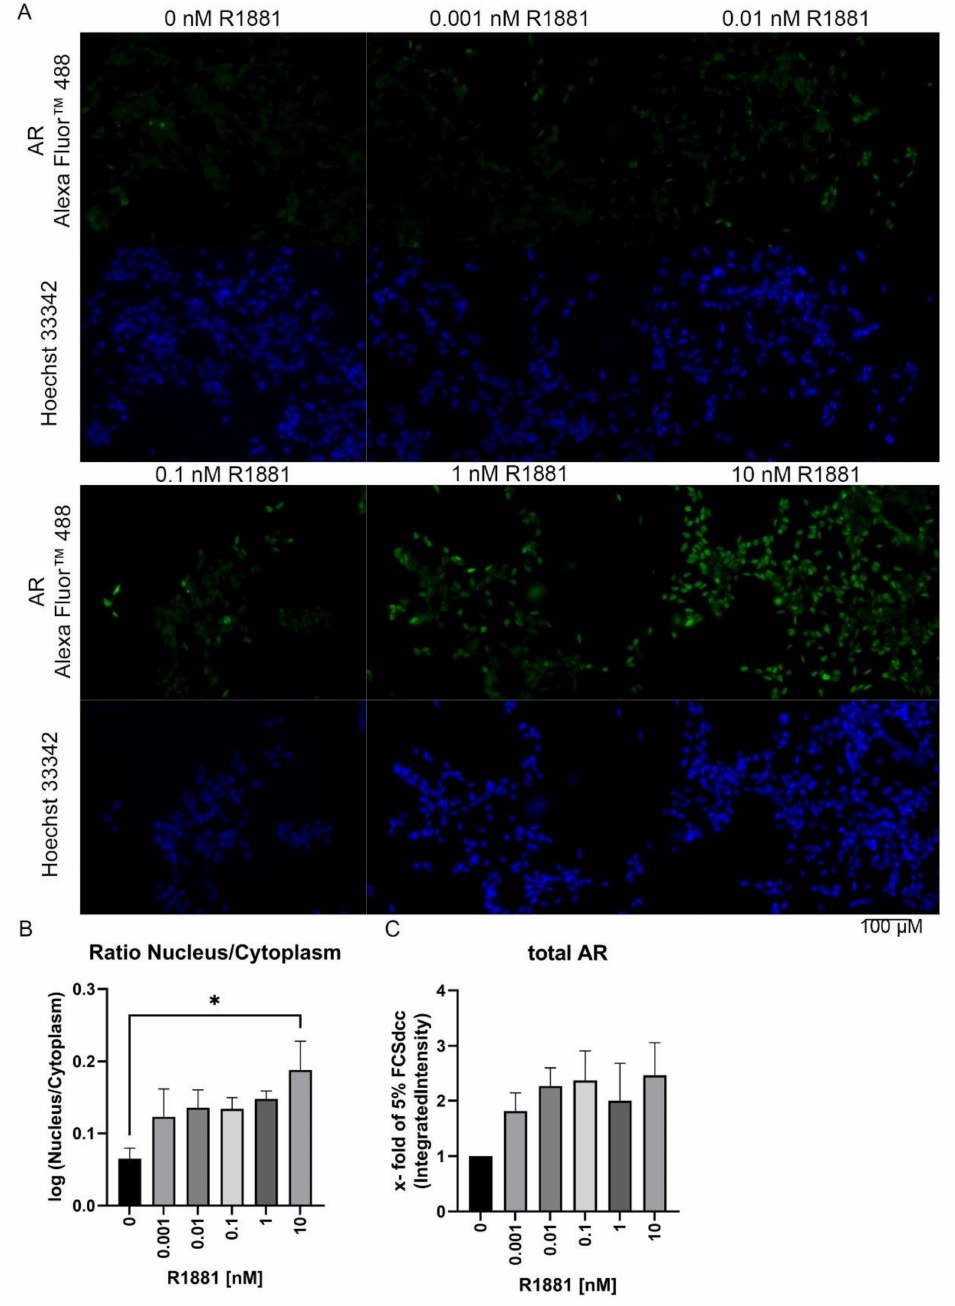
Figure 3. R1881 increases nuclear localisation in a concentration-dependent manner: ( A ) Represen- tative Immunofluorescence staining of R1881 (0–10 nM) treated LNCaP cells. Scale bar represents 100 µ M. ( B ) Nuclear to cytoplasmic ratio after 2 h of R1881 treatment in LNCaP cells. ( C ) Relative change of total AR after 2 h of R1881 treatment. Values are expressed as x-fold of untreated cells and are displayed as mean ± s.d. ( n = 3). All differences highlighted by asterisks were statistically significant (* p ≤